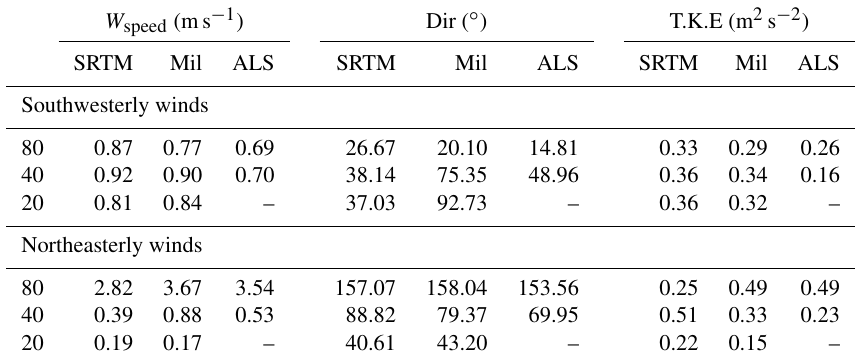
Table 8. RMSE of wind speed, wind direction and turbulent kinetic energy for tower 25/tse09.